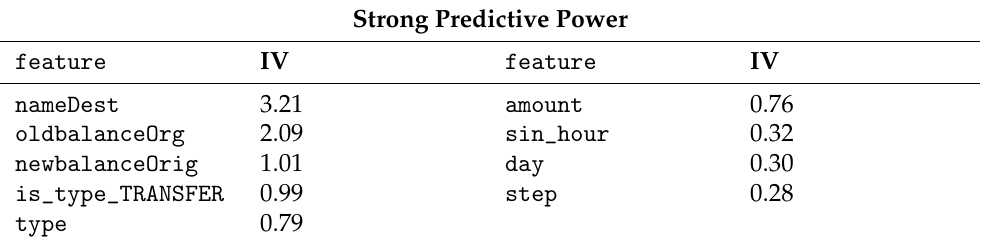
Table 13. Extended PaySim dataset information value—Part